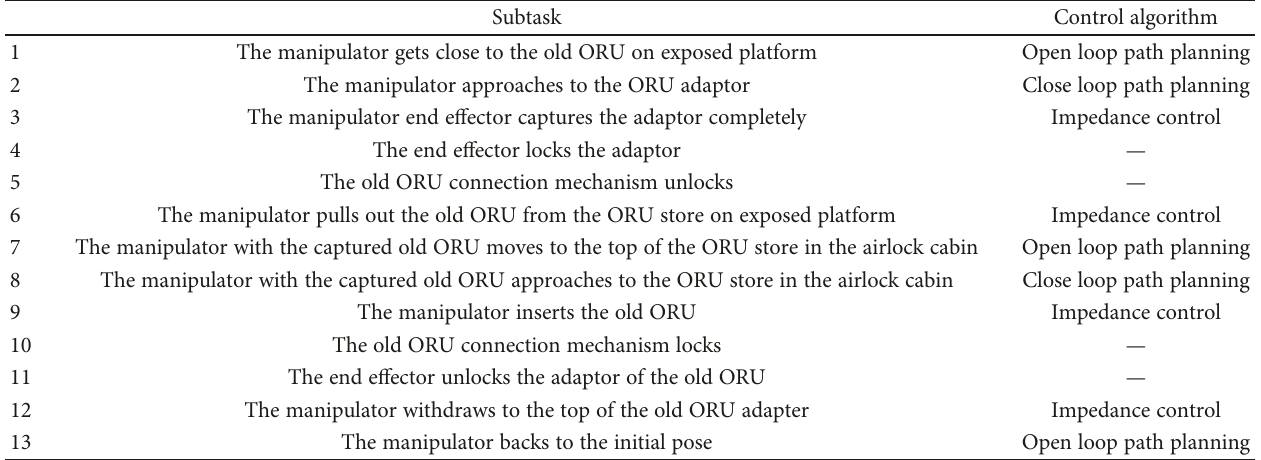
Table 1: Subtasks and corresponding control algorithms of the fi rst two